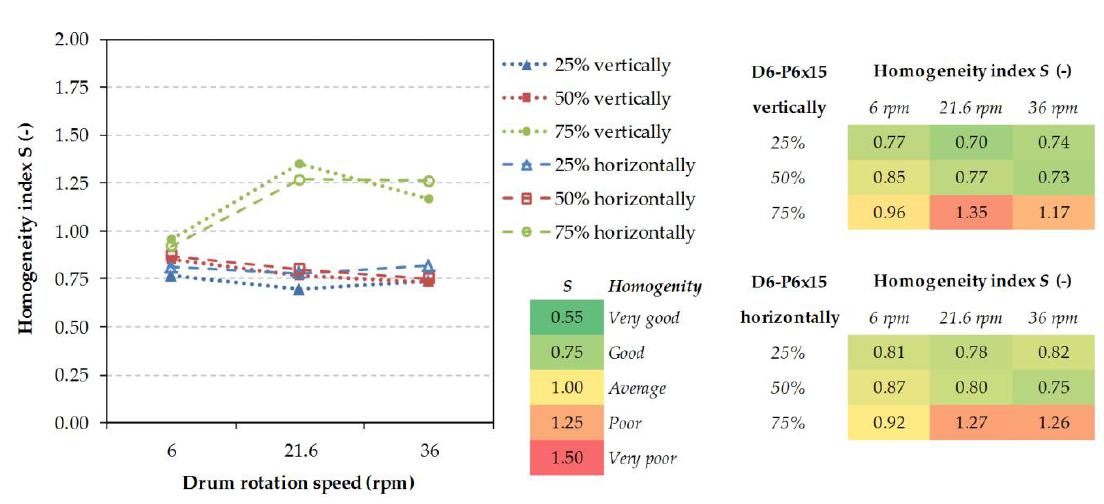
Figure 10. Resulting homogeneity indices for different operating conditions (D6-P6 × 15 particles).